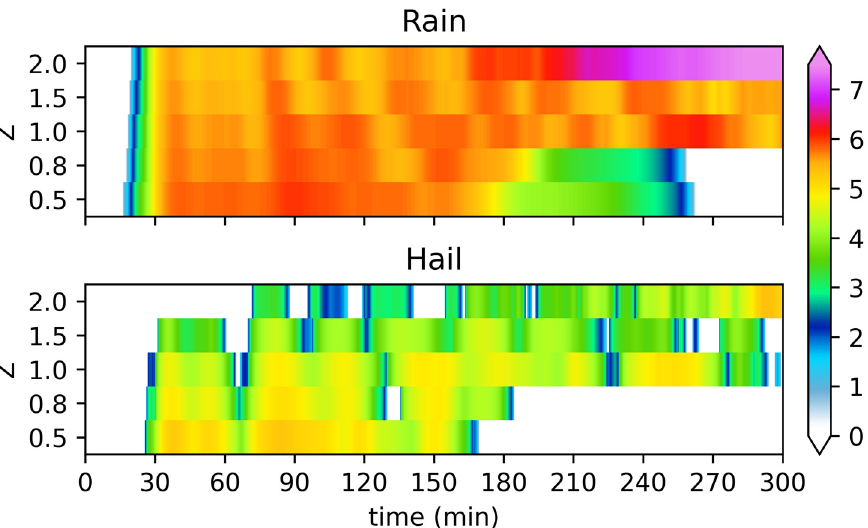
Figure 2. Temporal variation of the domain total precipitation intensity R (kg/s) of the rain and hail categories in the simulated storm with the Z factor for large domain simulations. The color scale is in units of 𝑙𝑜𝑔 (cid:2869)(cid:2868) 𝑅 .